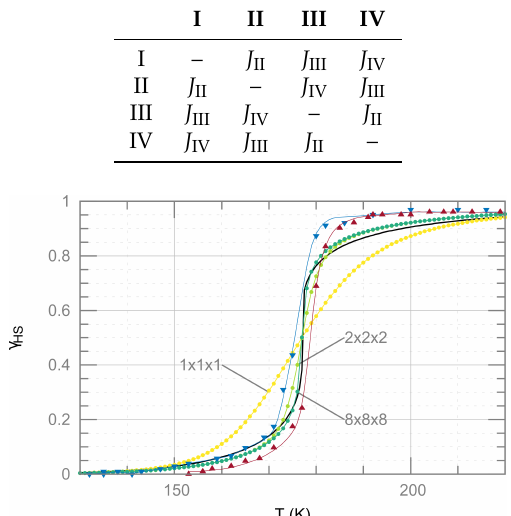
Figure 3. Measured and calculated temperature-dependent HS fraction γ HS ( T ) of [Fe(phen) 2 (NCS) 2 ]. Measured values which are extracted from susceptibility data from Gütlich et al. [37] (disregarding the residual HS fraction of about 17%) show a narrow hysteresis of about 2 K between the curves obtained upon heating and cooling ( (cid:52) and ∇ , respectively, the thin lines are guides to the eyes). The thick black line represents the transition curve obtained from the Slichter–Drickamer model (SDM) by solving Equation (4) with Γ = 3 kJ · mol − 1 , using a self consistent iterative procedure. The results of Monte Carlo (MC) simulations for supercells of different sizes as indicated are represented by filled